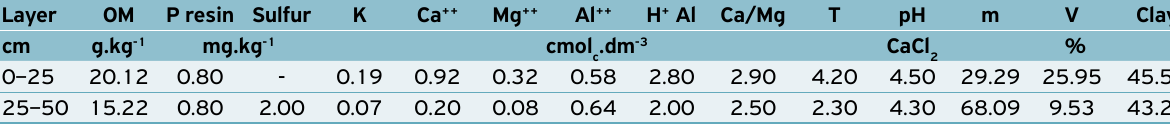
Table 1. Soil chemical characterization of the experimental area. Layer OM